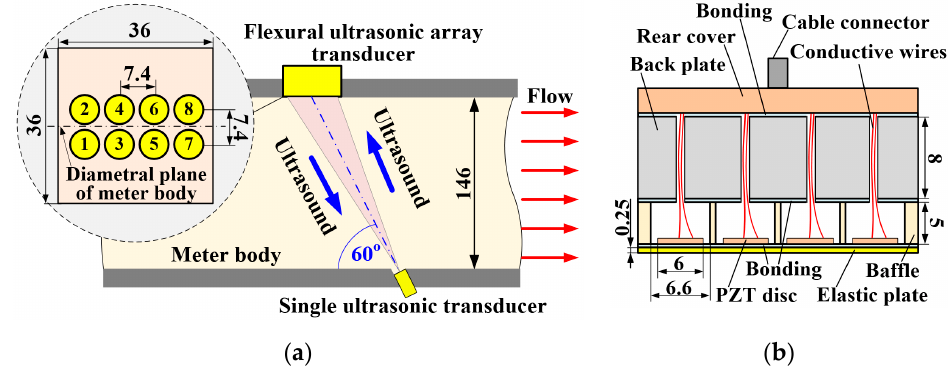
Figure 1. Schematic diagrams of the flow meter system, showing ( a ) the position of the ultrasonic transducers inside the meter body, and ( b ) the construction of the flexural ultrasonic array transducer. All dimensions are in millimeters.